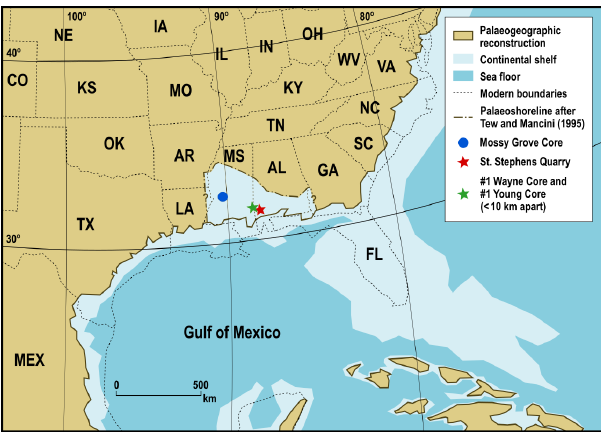
Figure 1. Palaeogeographic reconstruction showing location of the Mossy Grove, #1 Wayne and #1 Young cores, as well as St. Stephens Quarry outcrop. Main North American palaeogeogra- phy at ∼ 35Ma follows Deep Time Maps™ (https://deeptimemaps. com/, last access: 16 October